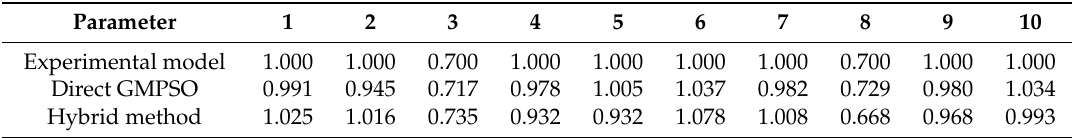
Table 1. Parameter values of updated and experimental model with different methods.